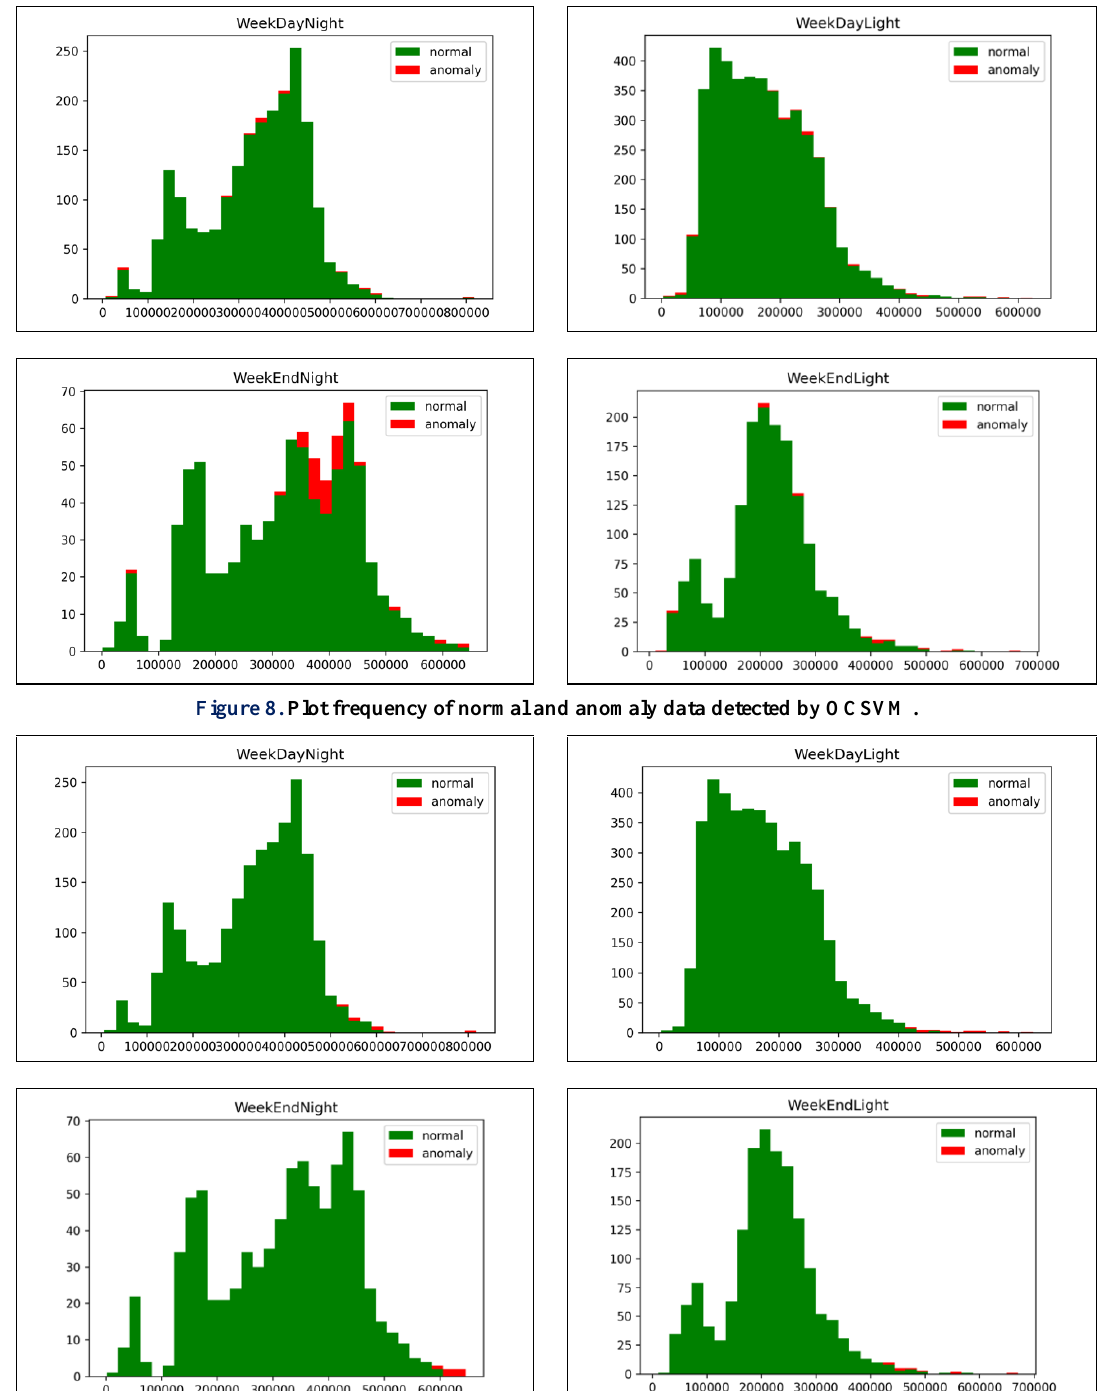
Figure 9. Plot frequency of normal and anomaly data detected by